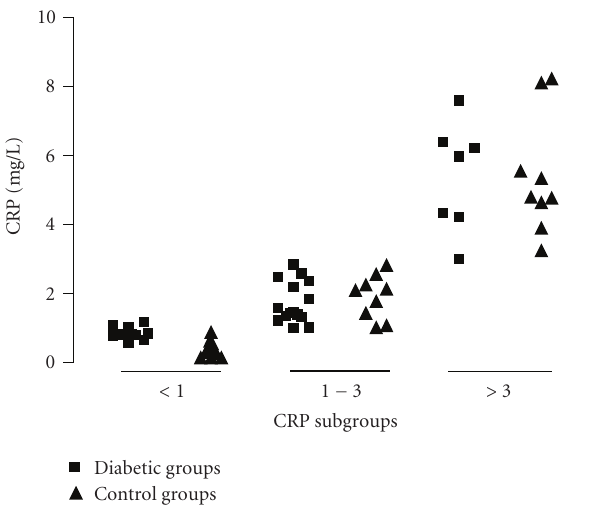
Figure 1: Distribution of CRP in diabetic ( (cid:2) ) and control ( (cid:3) ) groups. Data are shown using three simple clinical cut-o ff points for CRP: less than 1, 1 to 3, and greater than 3mg/L.